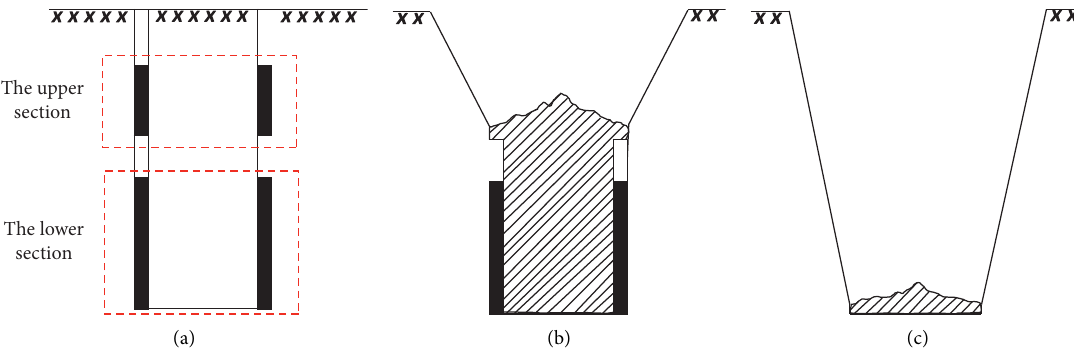
Figure 2: Diagram of two-step cut blasting. (a) Profile diagram of two-step cut blasting in a vertical shaft. (b) Profile diagram after the upper section detonation. (c) Profile diagram after the lower section detonation.